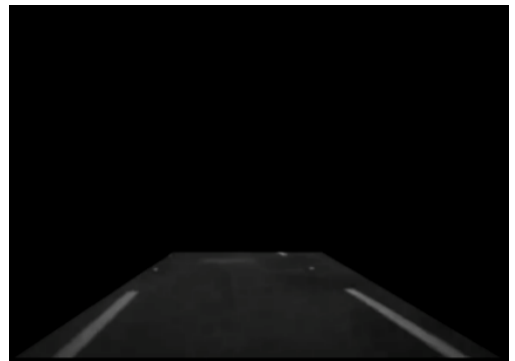
Figure 6. Selection of the area of